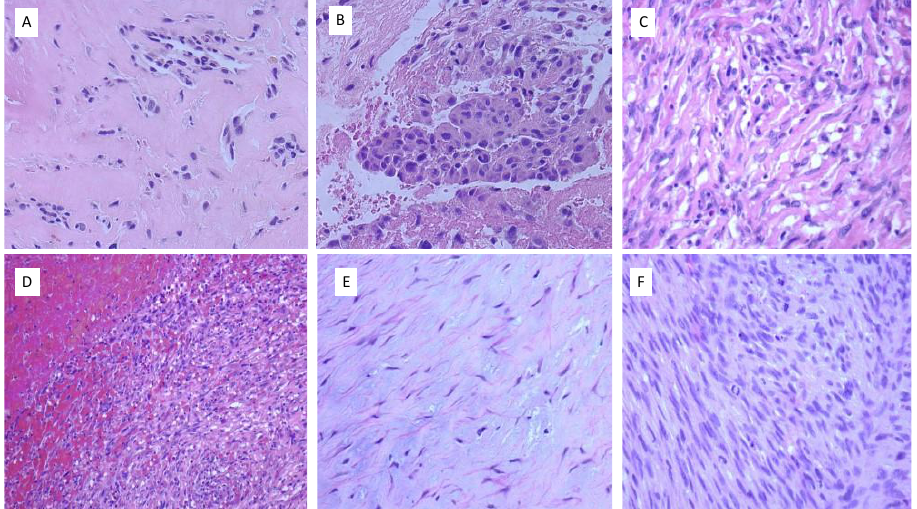
Figure 2. Morphological patterns of IS. ( A ) IS with strong hyalinized areas in the primary tumor of case 1 (H&E, 40×). ( B ) Neoplastic cells with epithelioid features, moderate nuclear pleomorphism, and some mitotic figures (H&E, 40×). ( C ) Spindle neoplastic cells in a fibrous and intense inflamma- tory stroma in case 2 (H&E, 40×). ( D ) Spindle cell tumor with extensive hemorrhagic areas in case 3 (H&E, 20×). ( E ) Paucicellular tumor areas within a rich myxoid matrix in case 3 (H&E, 40×). ( F ) Dense spindle-cell proliferation with high mitotic activity in the xenografted tumor (H&E, 40×).